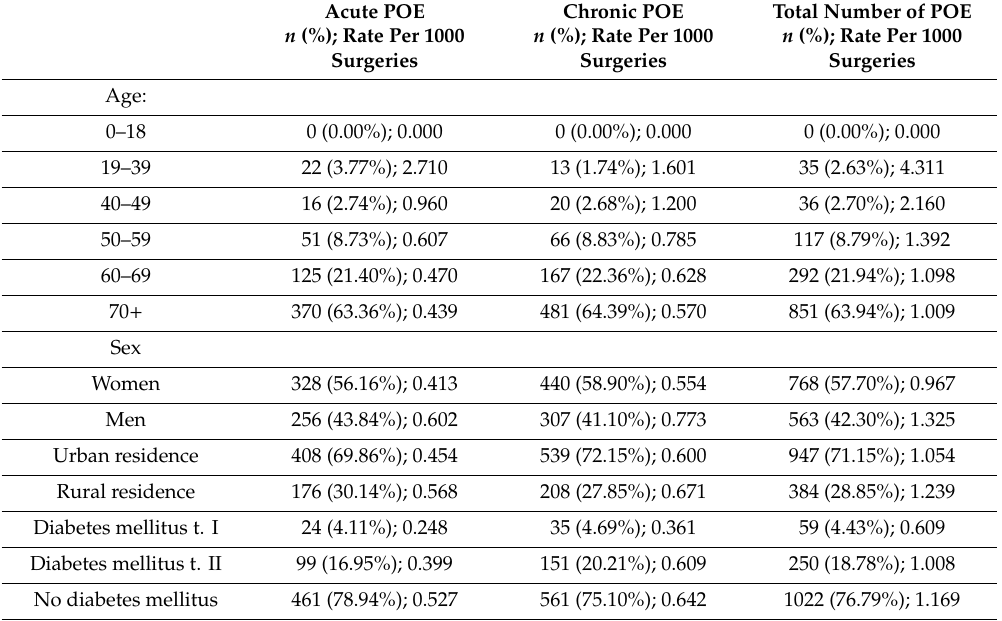
Table 3. Demographic characteristics of all postoperative endophthalmitis (POE) cases after cataract surgery in Poland during 2010–2015.